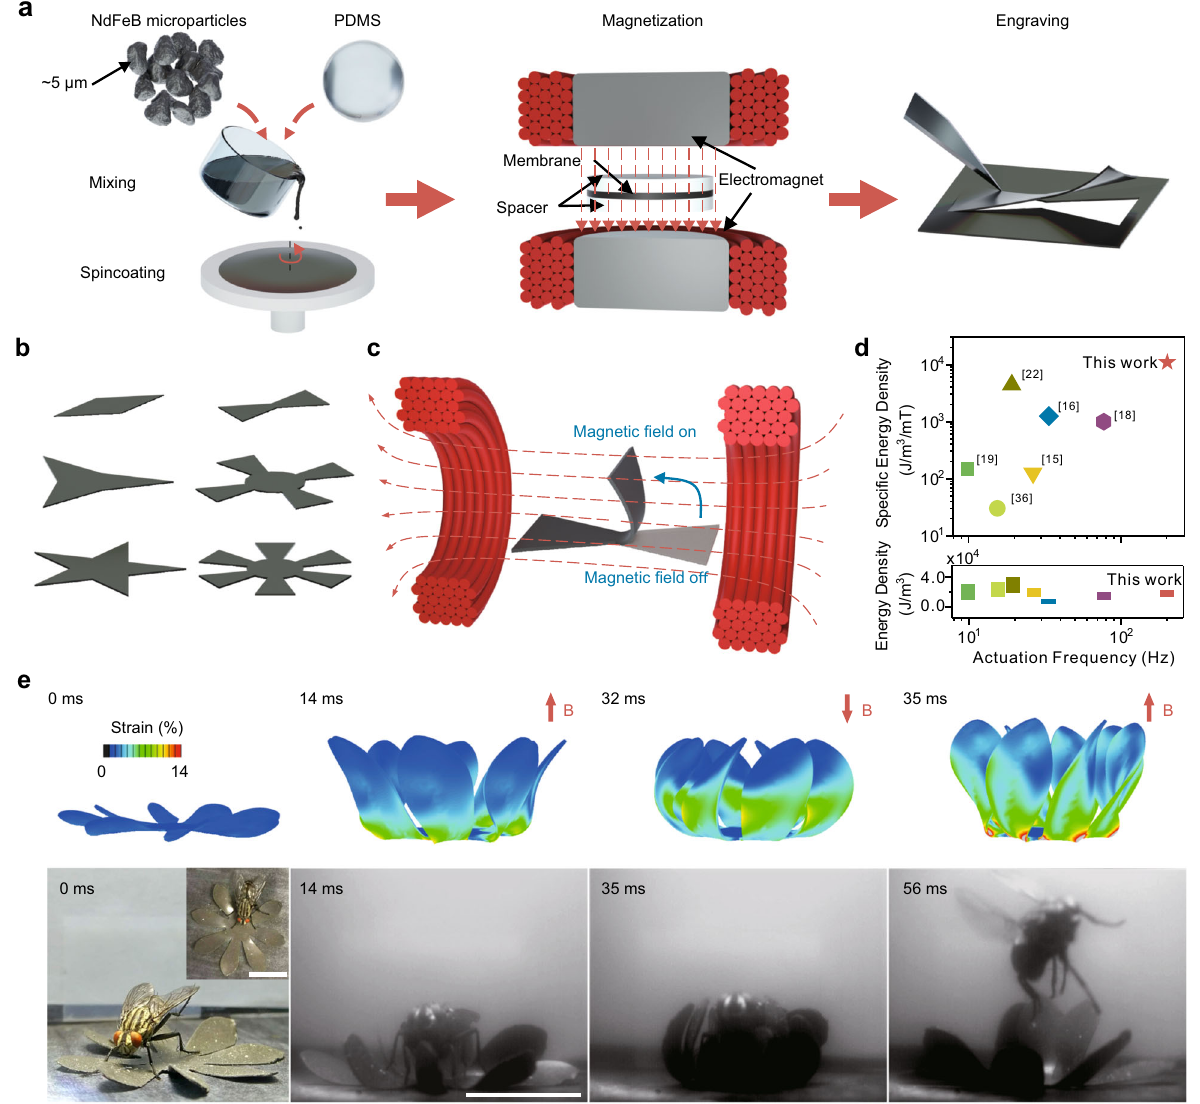
Fig. 1 Ultrafast, lightweight, and resilient magnetic soft-bodied robots. a Illustration of the preparation steps for NdFeB/PDMS membrane-based magnetic soft robots. A magnetic composite is fabricated by mixing NdFeB microparticle fi llers with PDMS at high loading ratios of 70 wt% magnetic solids. Subsequent spin-coating yields thin (down to 7 μ m) elastomeric membranes that are magnetized by an out-of-plane magnetic fi eld induced by an electromagnet. A ready-to-use magnetic soft robot is obtained by high throughput engraving or cutting of the magnetic membranes. b , c Schematic diagram showing different types of multi-arm robots, as well as the setup (two electromagnetic coils) used to achieve untethered robot actuation. d Performance (energy density and speci fi c energy density) of our magnetic soft robots compared to other approaches 15,16,18,19,22,36 . e Simulated (top row) and experimental (bottom row) results of a fl ower-shaped magnetic soft robot highlight the predictive nature of our dynamic model and the versatile applicability of the robot due to its fast and silent actuation. It closes around a living fl y momentarily and releases it again without harming the fragile insect (Supplementary Movie 2). Scale bars, 1